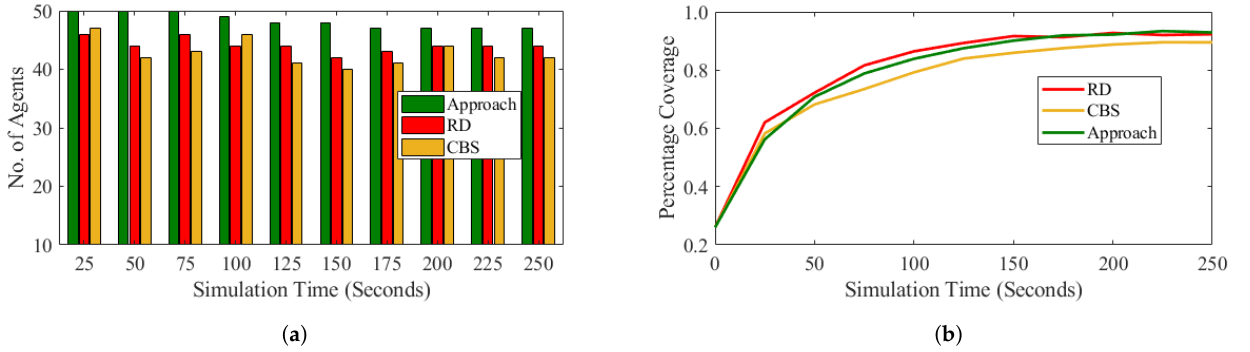
Figure 6. Performance of different algorithms on coverage and connectivity constraint satisfaction. ( a ) Connectivity constraint satisfaction of different algorithms. ( b ) Coverage rate of different algorithms. Table 1. Performance comparison with heuristic